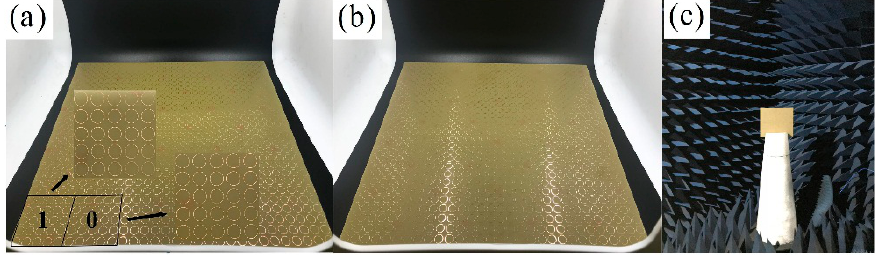
Figure 7. The matrix-type random coding MS templates: ( a ) coding a ; ( b ) coding b ; and ( c ) the measurement setup at microwave anechoic chamber.